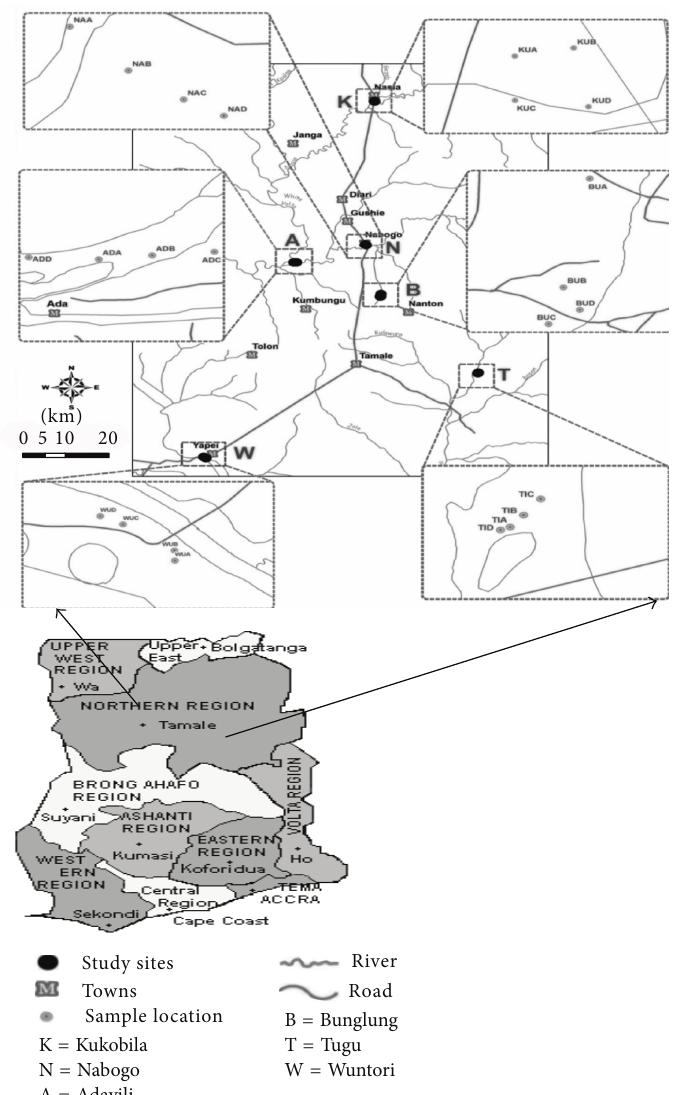
Figure 1: Map of the study areas, showing the location of the wetlands in the floodplains of the White Volta River catchment, Northern